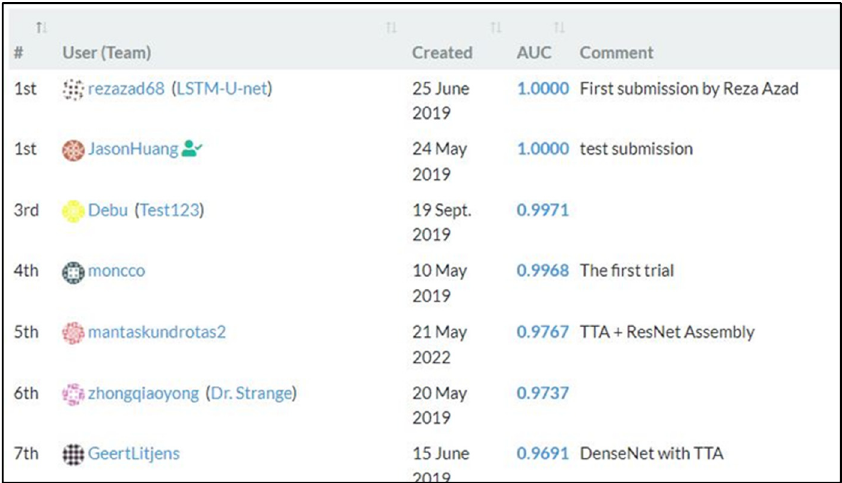
Figure 6. “Patch Chameleon” standings. The result of this work is in the fifth place—marked 5th.